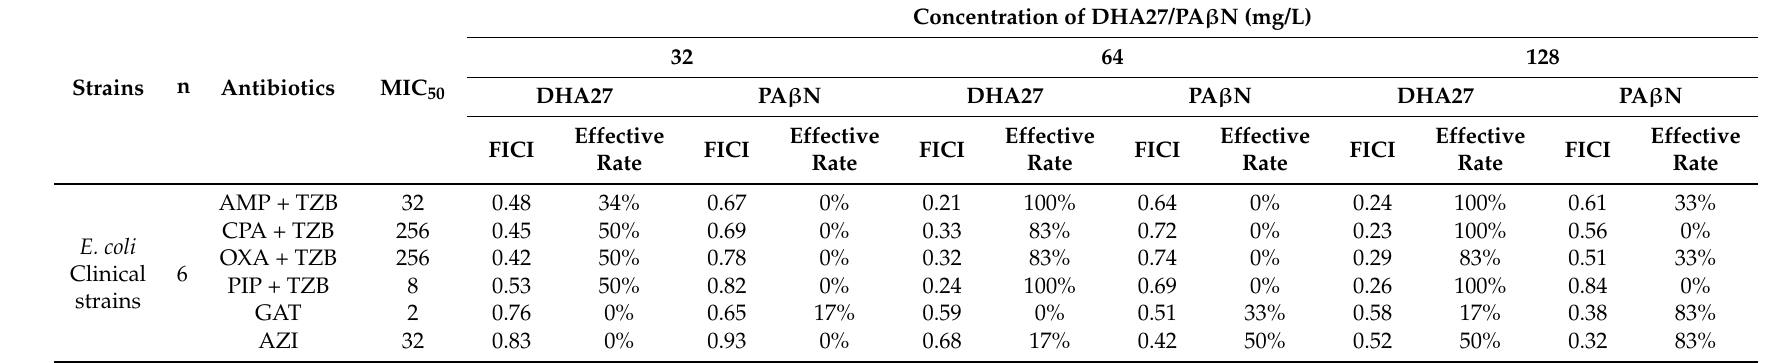
Table 3. Effect of DHA27 and PA β N on antibacterial effects of six antibiotics on six E. coli